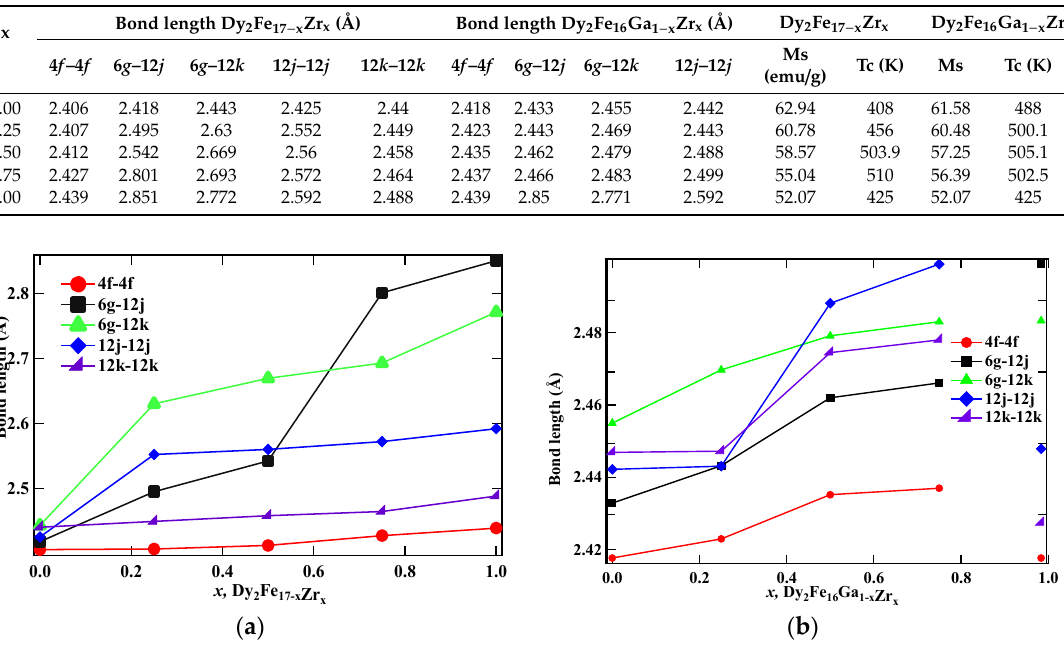
Figure 4. Dependence of bond lengths on x of ( a ) Dy 2 Fe 17 − x Zr x , and ( b ) Dy 2 Fe 16 Ga 1 − x Zr x . Table 3. Distance between the Fe–Fe neighbor sites, Ms, and Tc for Dy 2 Fe 17 − x Zr x and Dy 2 Fe 16 Ga 1 − x Zr x .